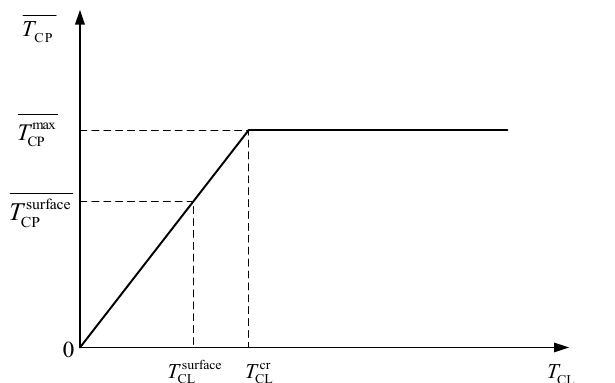
Figure 6. Relationship between the average thickness of the rust-filling layer and the thickness of the rust layer.